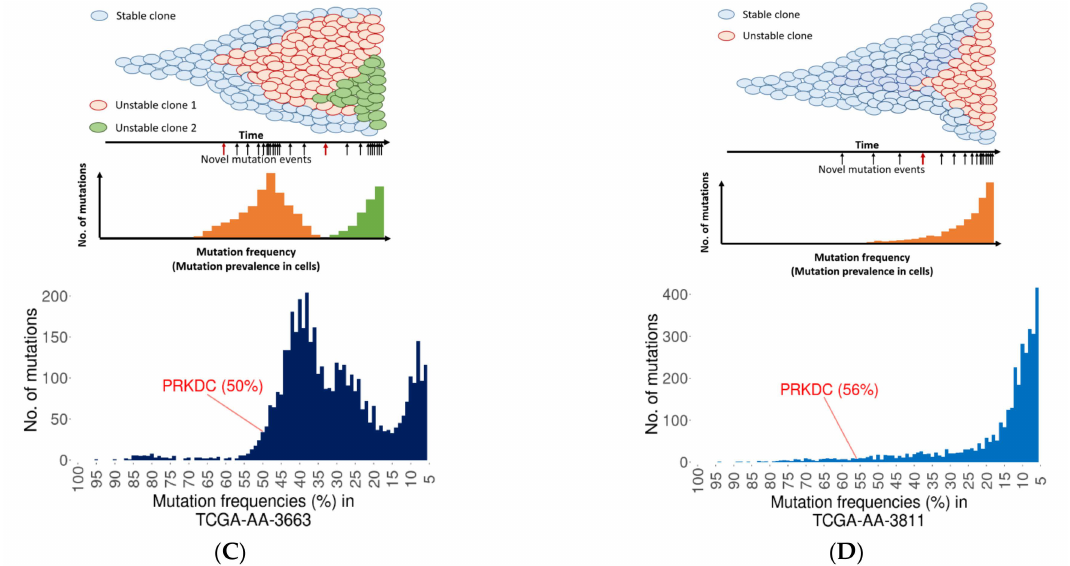
Figure 2. Founder mutations lead to an increased mutation load. Theoretical histogram showing the number of genes with a mutation as a function of the mutation frequency in a sample ( A ). The area under the curve (AUC) equals the total mutation burden (TMB) in a sample. Theoretical and actual representation using a representative example (with TCGA sample identifier) of founder mutation and different mutation load patterns in colorectal cancer patients with a single ( B ), double ( C ), and exponential ( D ) clonal expansion. The red arrows show the incidence of the founder mutation. Mutations in the PRKDC gene are indicated in the TCGA